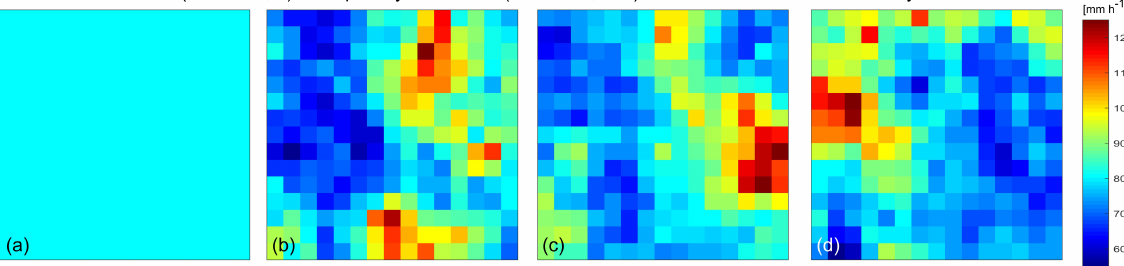
Figure 4. An example of STREAP’s ability to spatially distribute the annual maxima rainfall intensity over the catchment. The annual maxima recorded by the Lucerne gauge for the year 1981 is 80.4mmh − 1 for a duration of 10min. Without STREAP, this value is assumed to be uniformly distributed over the domain (a) . STREAP accounts for the spatial distribution of rainfall; thus, while the areal average is preserved for each time step, some grid cells (100m × 100m resolution) will record higher rainfall intensity and some lower values. Examples of the footprint of the annual maxima rainfall intensity for three random realizations of the year 1981 generated by STREAP are presented in (b) – (d)